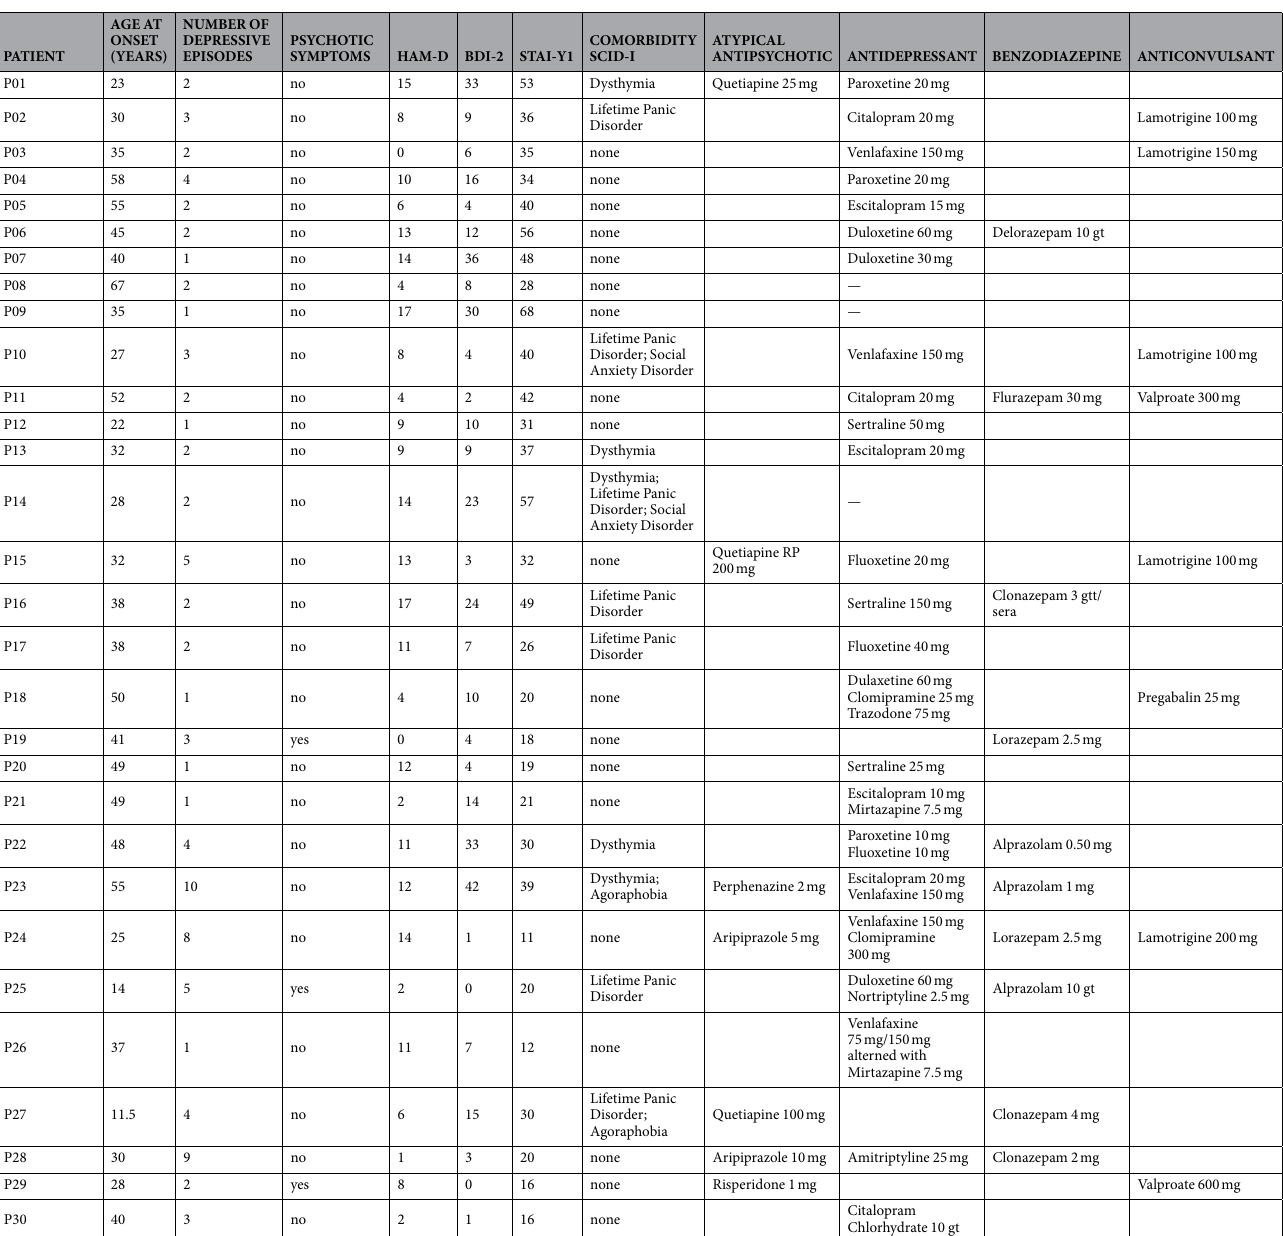
Table 1. Demographic and clinical characteristics of MMD patients, average scores obtained to the Italian version of Hamilton Rating Scale for Depression (HAM-D; Hamilton, 1980), Beck Depression Inventory-II (BDI-II; Beck et al . 1996) and State-Trait Anxiety Inventory-Y1 (STAI-Y1, State version; Spielberg et al . 1983), and patients’ drug